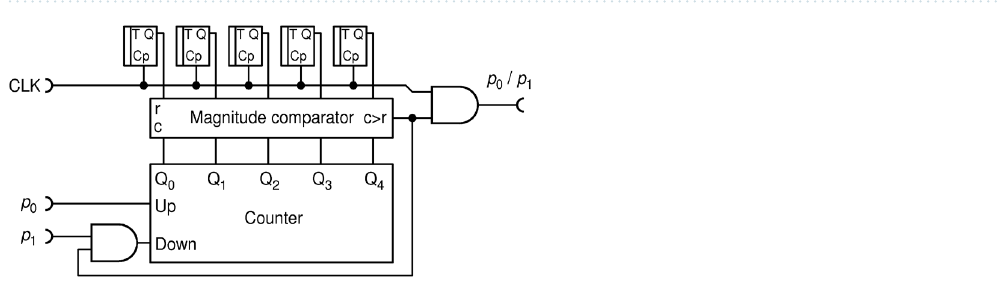
Figure 10. The improved division circuit DIV2 uses of T-type random flip-flops as internal source of entropy.